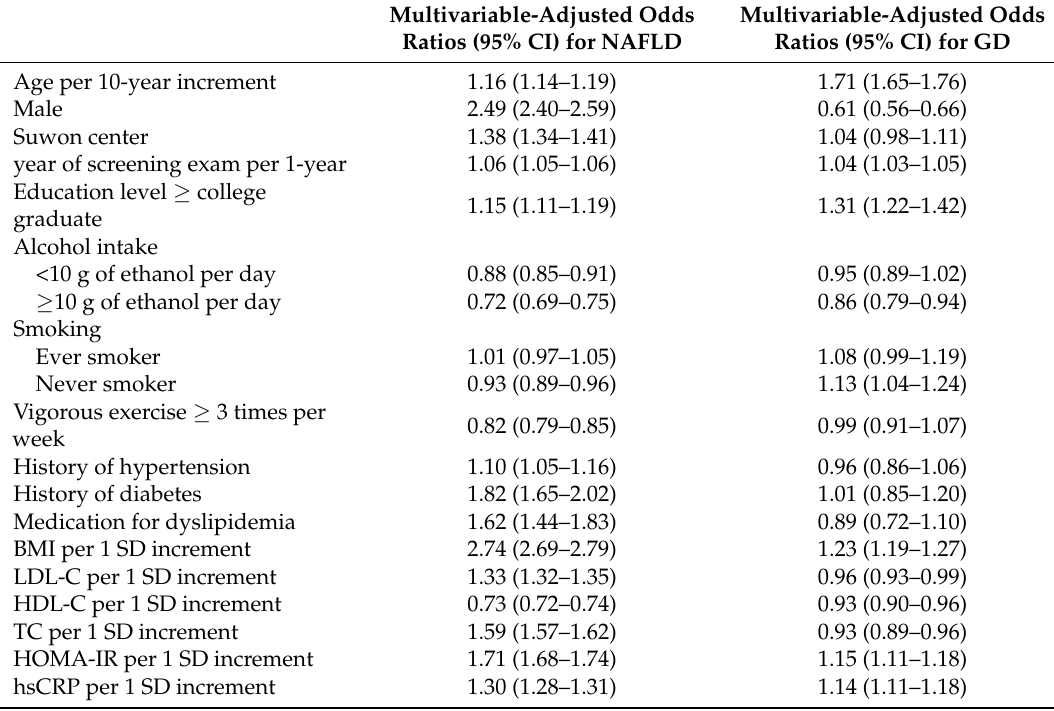
Table A4. The factors associated with NAFLD and GD at baseline before prospective longitudinal analysis from which persons with NAFLD or GD at baseline were